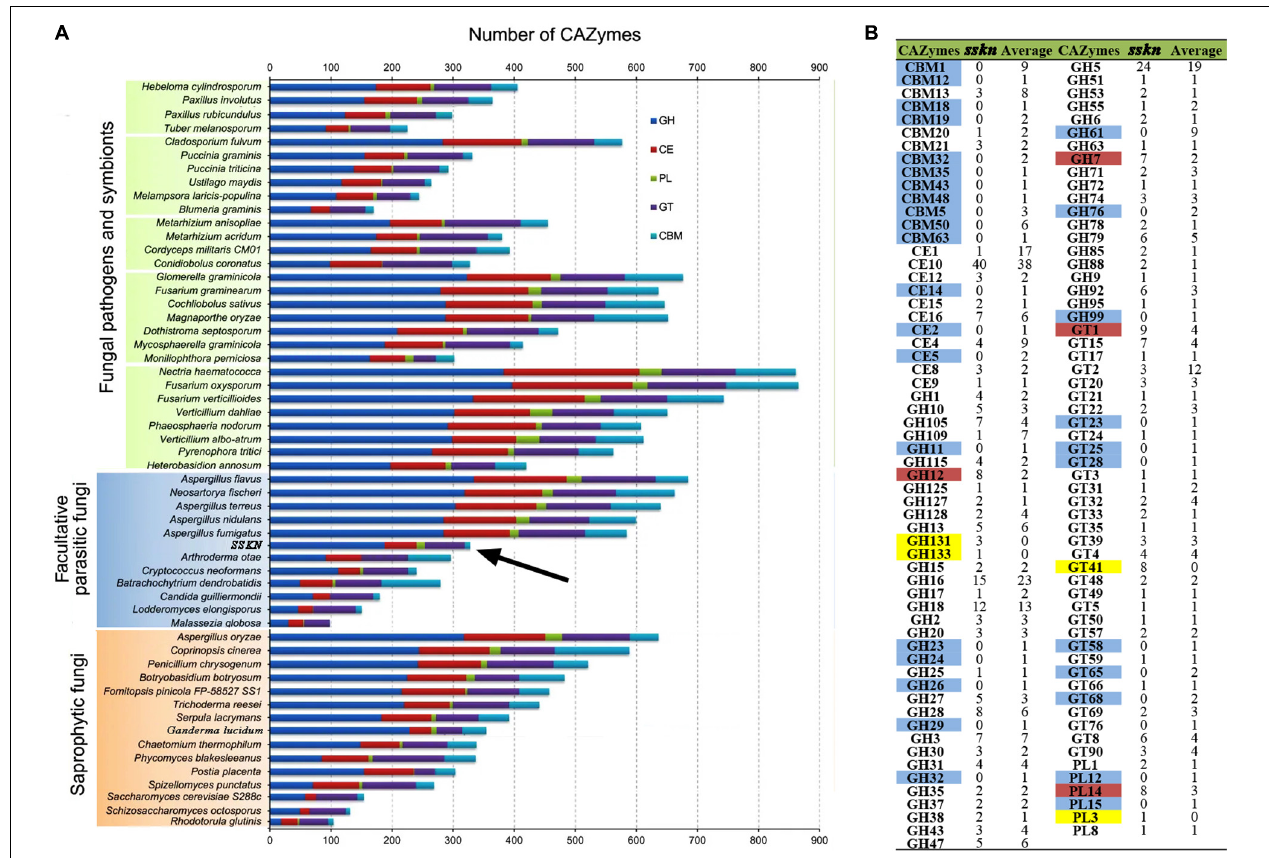
FIGURE 4 | Comparative analysis of CAZymes from S. sanghuang Kangneng and other fungi. (A) Comparative analysis of fungal CAZymes. The numbers of CAZyme modules or domains are represented as horizontal bars. (B) Average number of CAZymes from a total of 30 Basidiomycota fungi. Blue, CAZyme present in other Basidiomycota fungi but not in SSKN ; Red, number of CAZymes present in SSKN greater than one-fold the average number of other Basidiomycota fungi; Yellow, CAZymes only present in SSKN . SSKN , S. sanghuang Kangneng .